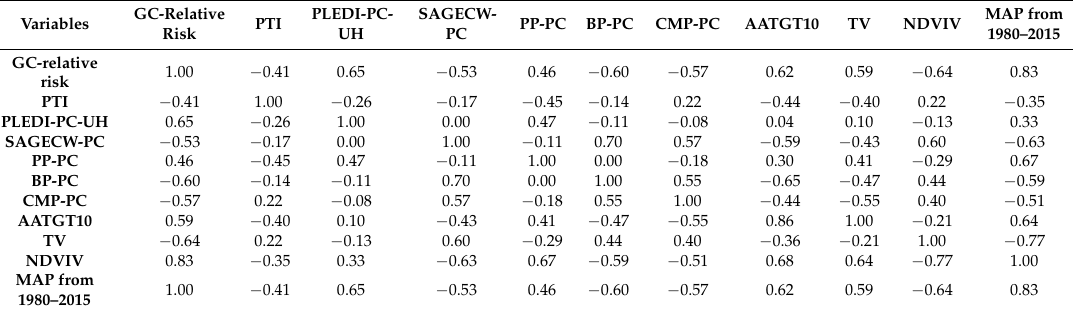
Table 1. The Pearson correlation coefficients between each pair of the GC relative risk and the 10 significantly associated